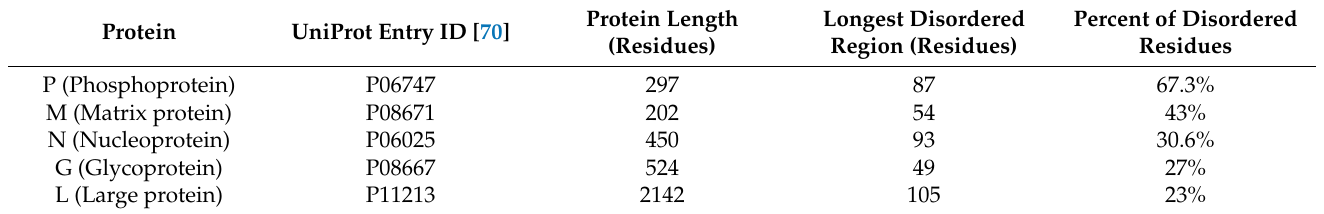
Table 1. Proteins in the rabies PV proteome and their evaluated percentages of intrinsically disordered residues as determined by the averaged predicted